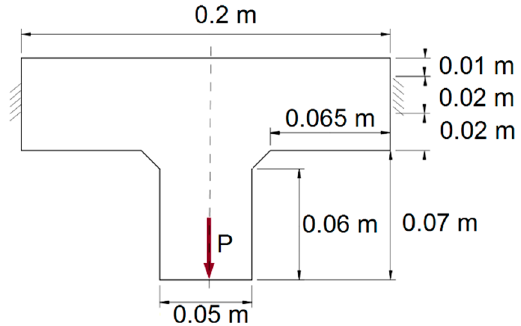
Figure 22. The T-bracket example, an initial structure with applied loads and supports.